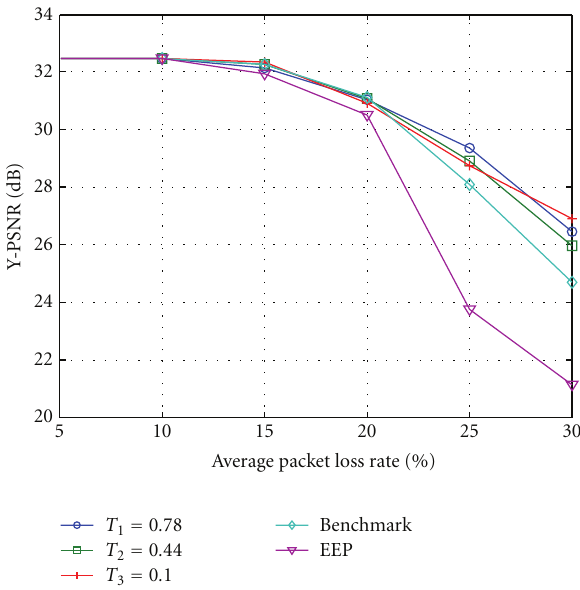
Figure 7: Optimized results for three values of T for the Paris